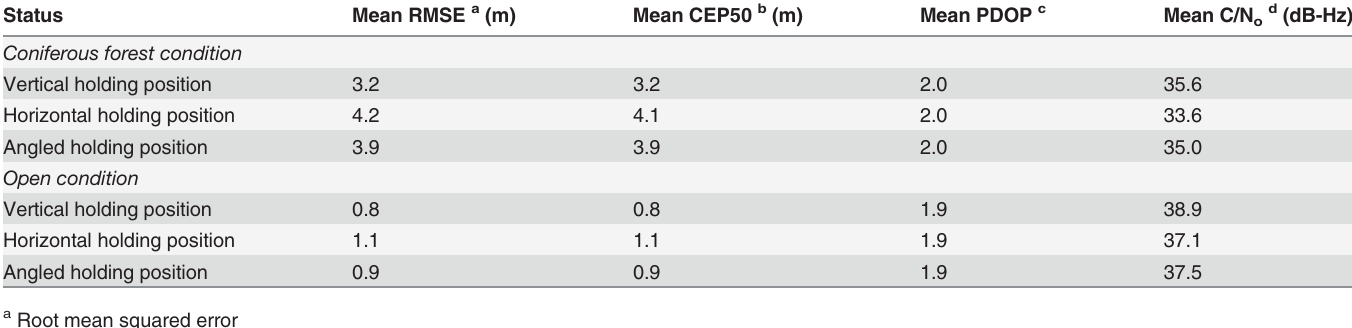
Table 7. Mean static horizontal position accuracy, PDOP, and signal-to-noise values for the Flint GNSS receiver in the second study, under leaf-off conditions ( n =